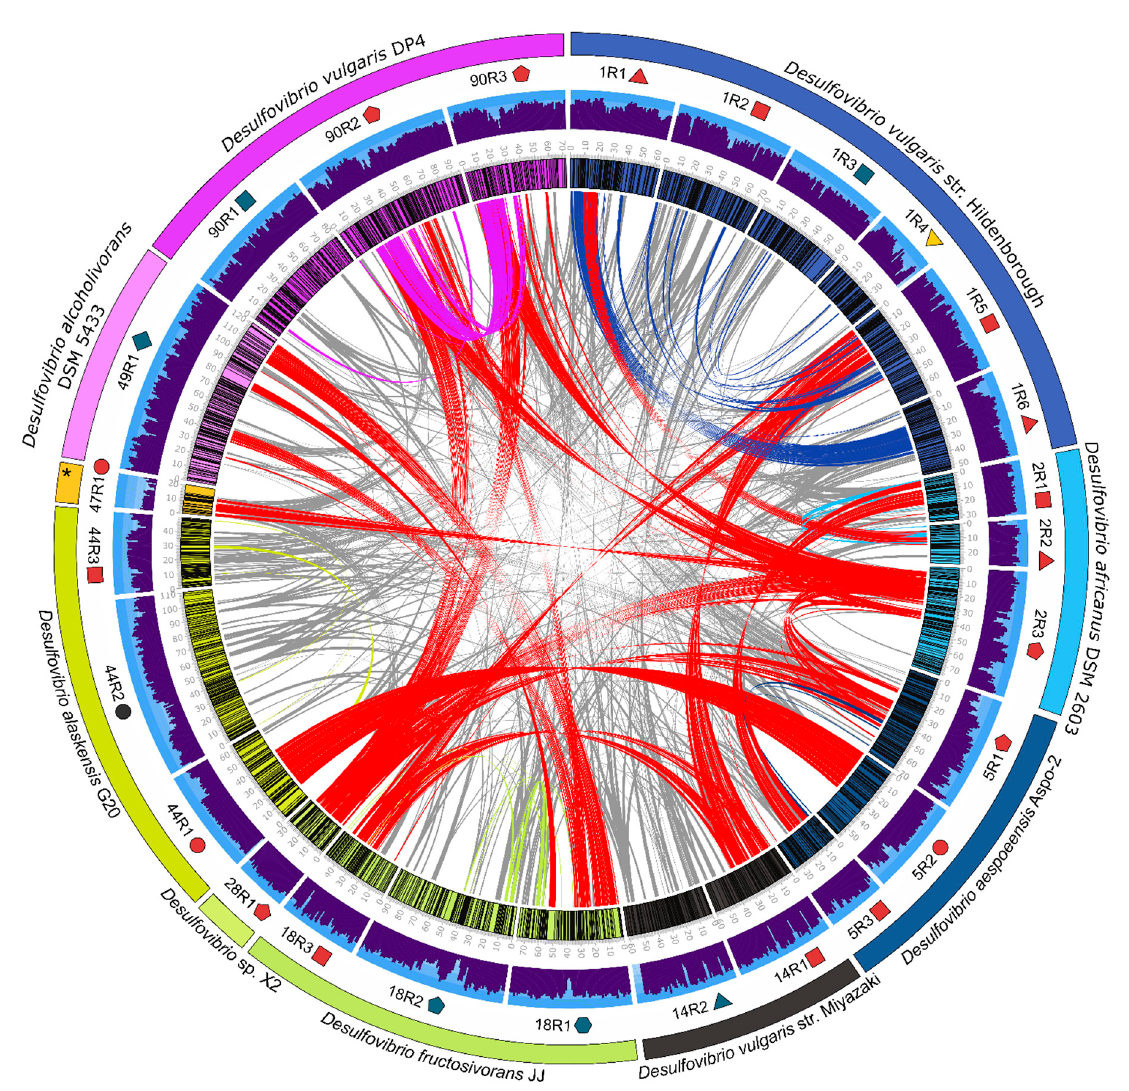
Figure 5. Circos plot shows the comparison of amino acid sequences among prophages of selected Desulfovibrio strains. Links show homologies between different prophage regions. Red connections indicate the most significant homologies between prophages from different hosts (more than 10 homologs), while gray links show prophages that share less than 10 homologs. Other colored connections show homologies between prophages from the same host. The symbols indicate the classification of each prophage according to VIRFAM (see Figure 1). The asterisk indicates the strain Desulfovibrio bastinii DSM 16055.